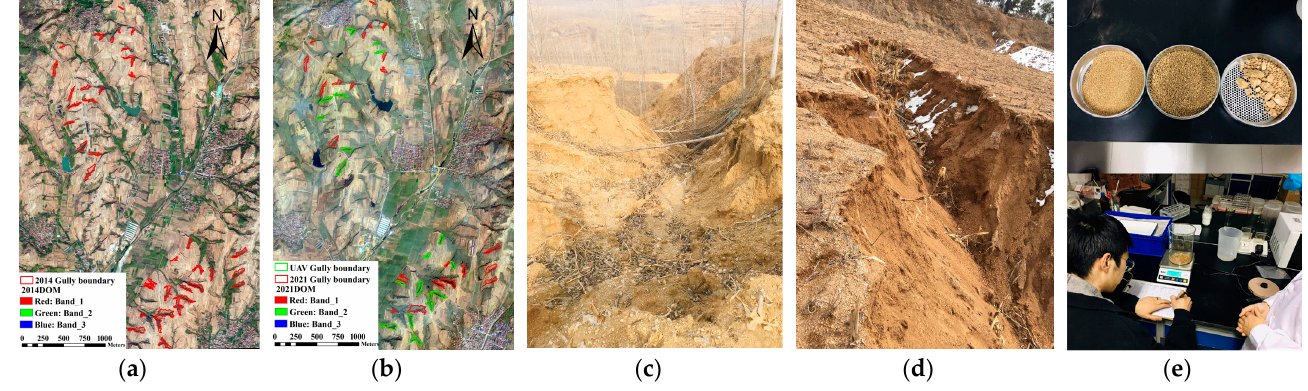
Figure 2. Gully distribution and introduction. ( a , b ) Map of gully distribution in high-resolution remote sensing stereo image pairs (ground sampling distance: 0.50 m) in 2014 and 2021, respectively. ( c , d ) Sample of a typical gully. ( e ) Experiment on soil-rock dual structure.